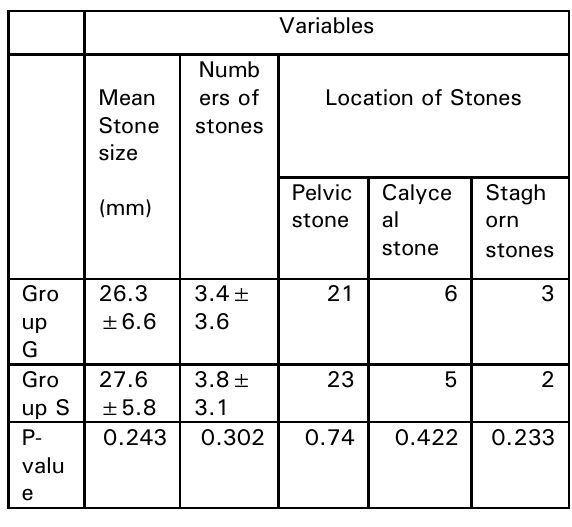
Table 3: Comparison of Anesthesia & Surgery